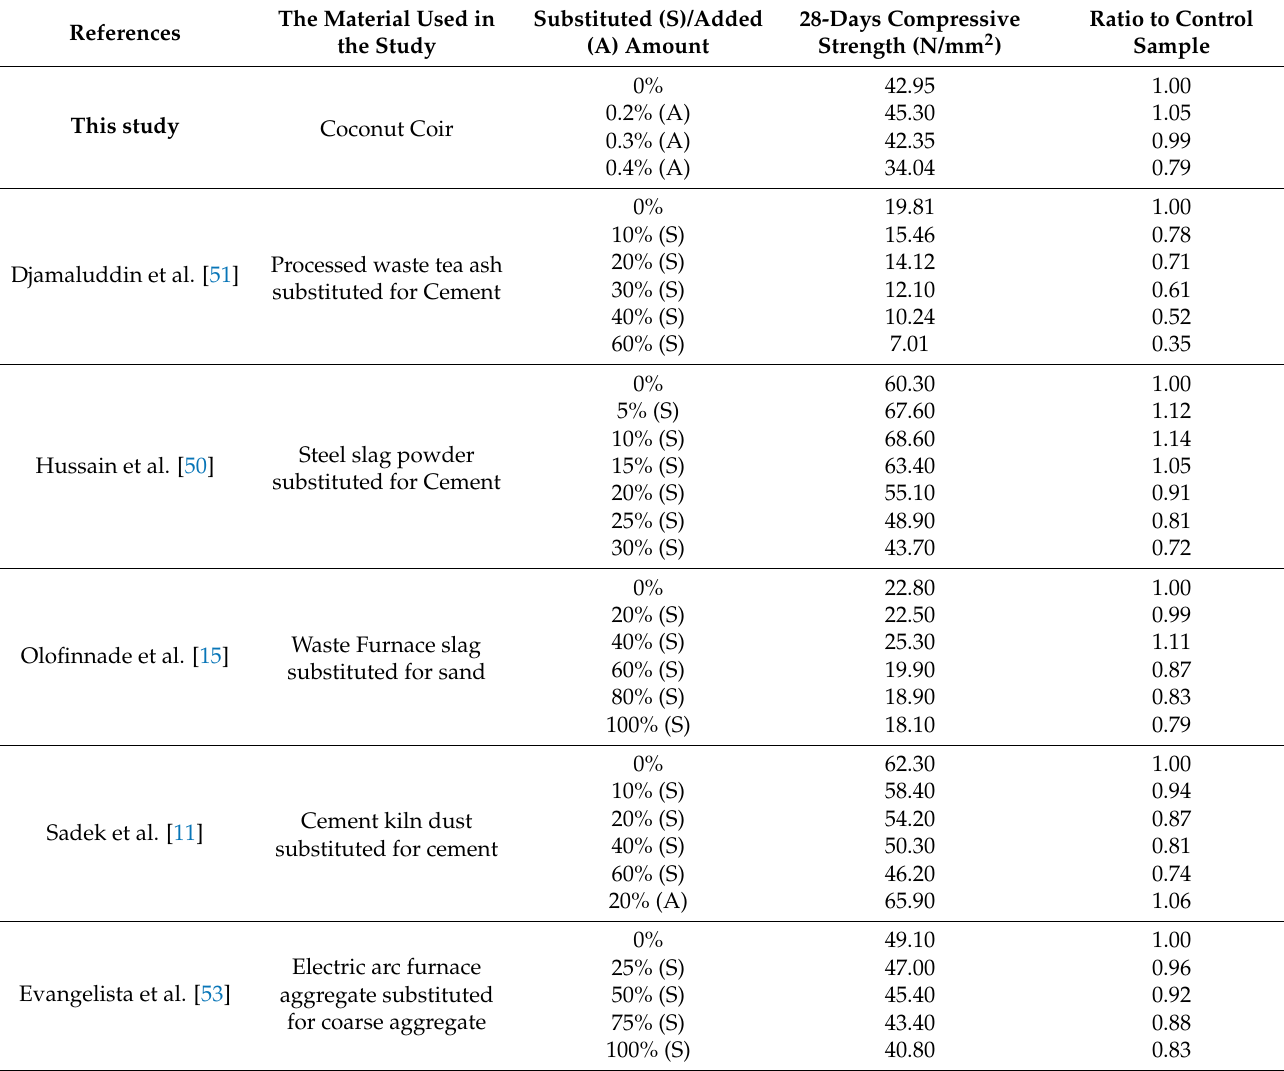
Table 9. Comparison of compressive strength of IPBs with other